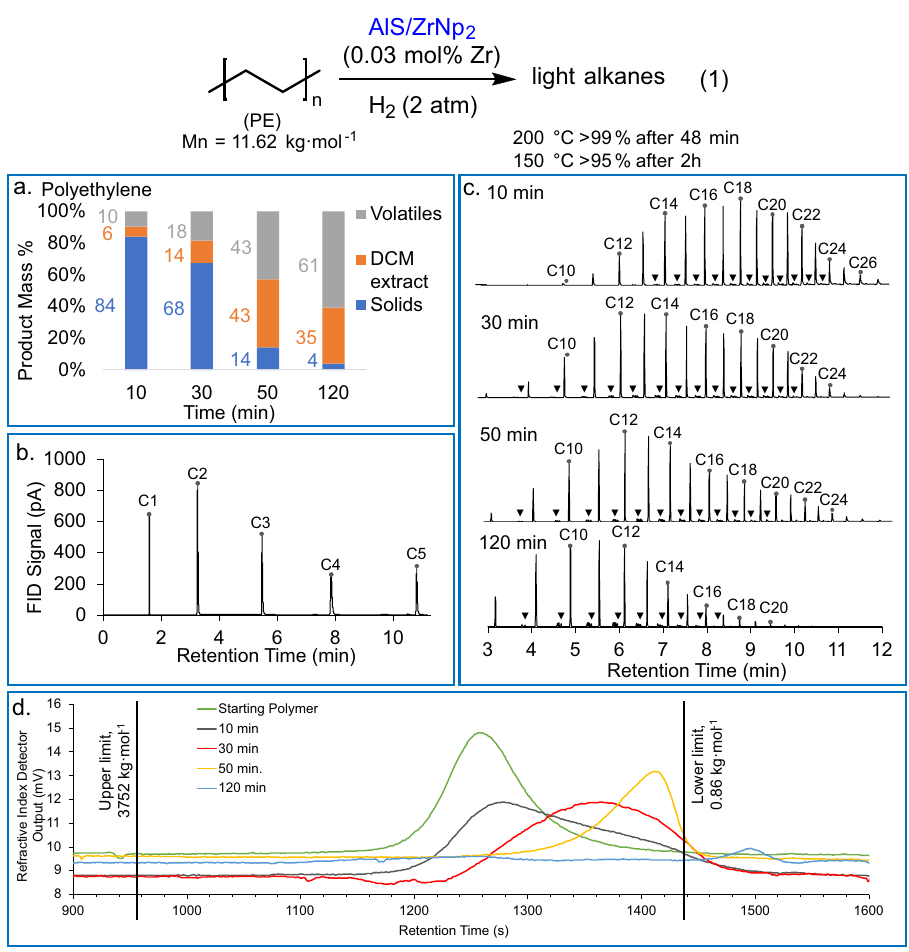
Fig.2|Catalytichydrogenolysisoflinearpolyethylene(PE).a Temporalproduct distributions for AlS/ZrNp 2 -catalyzed PE hydrogenolysis (150°C, 2.0atm H 2 , 0.03mol% Zr). b Headspace volatiles GC/FID chromatogram for 30min PE hydro- genolysis. c GC/MS chromatograms of DCM extracts from AlS/ZrNp 2 -catalyzed PE